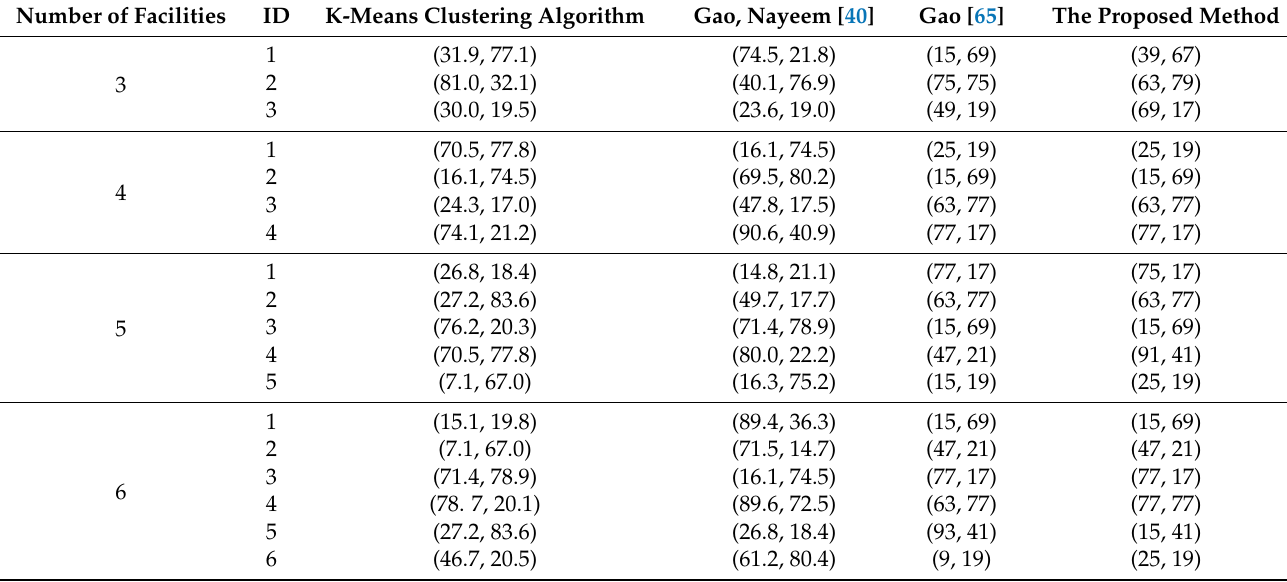
Table 7. Comparison of facility locations using different methods for Instance